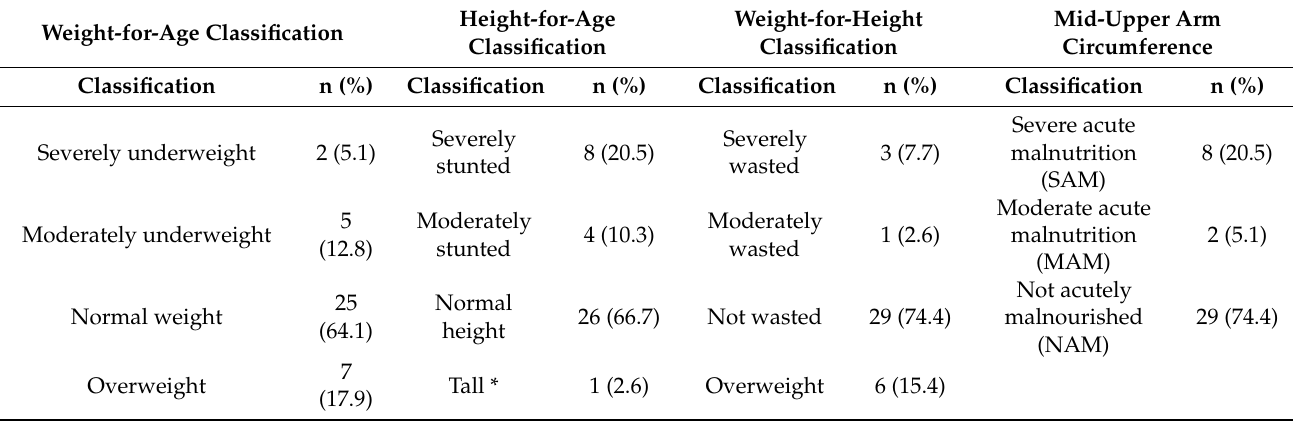
Table 2. Weight-for-age, height-for-age, weight-for-height, and MUAC classification in children 1–5 years (n = 39). Weight-for-Age Classification